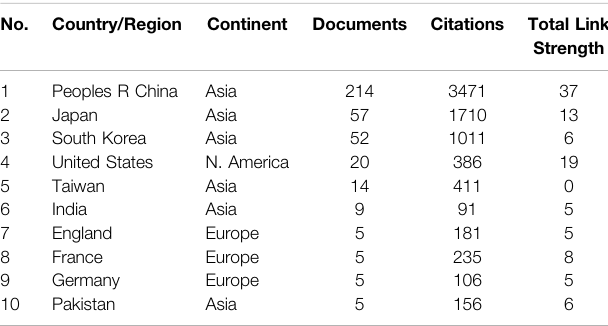
TABLE 2 | The top 10 countries/regions in Coptis